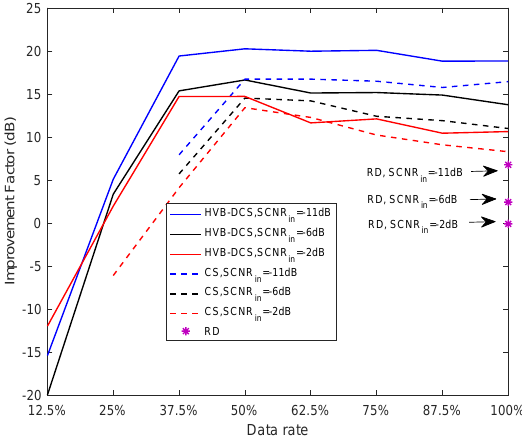
Figure 14. IFs of the RD, CS and HVB-DCS algorithms, based GMTI system for the varying data rates in azimuth and different SCNR in